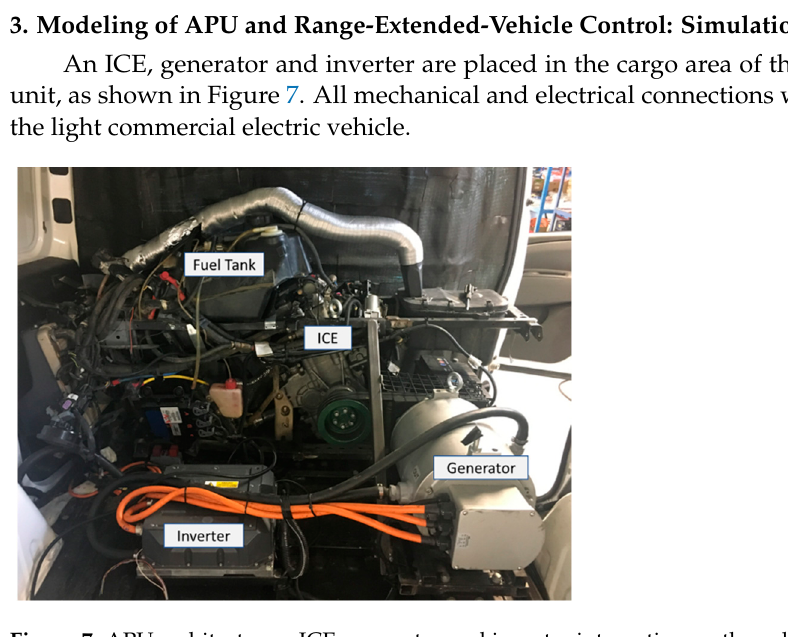
Figure 6. ICE horsepower − torque curve.